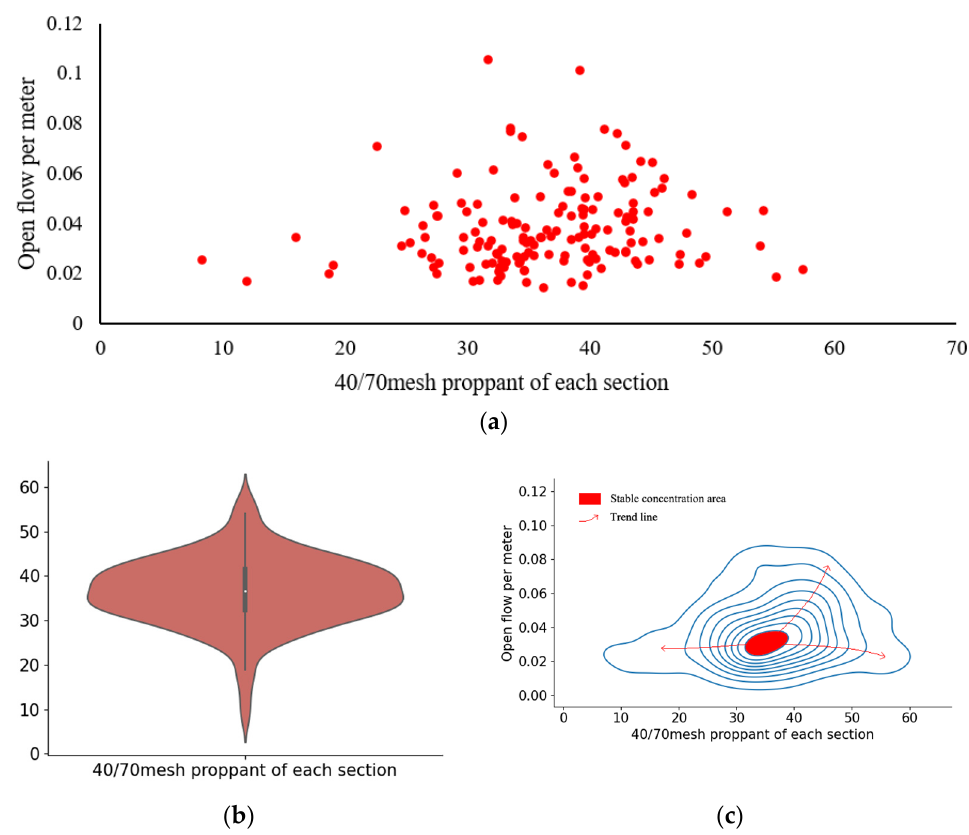
Figure 8. Analysis of 40/70 mesh proppant data. ( a ) Scatter plot of 40/70 mesh proppant; ( b ) violin plot of 40/70 mesh proppant; ( c ) binary KDE plot of 40/70 mesh proppant.